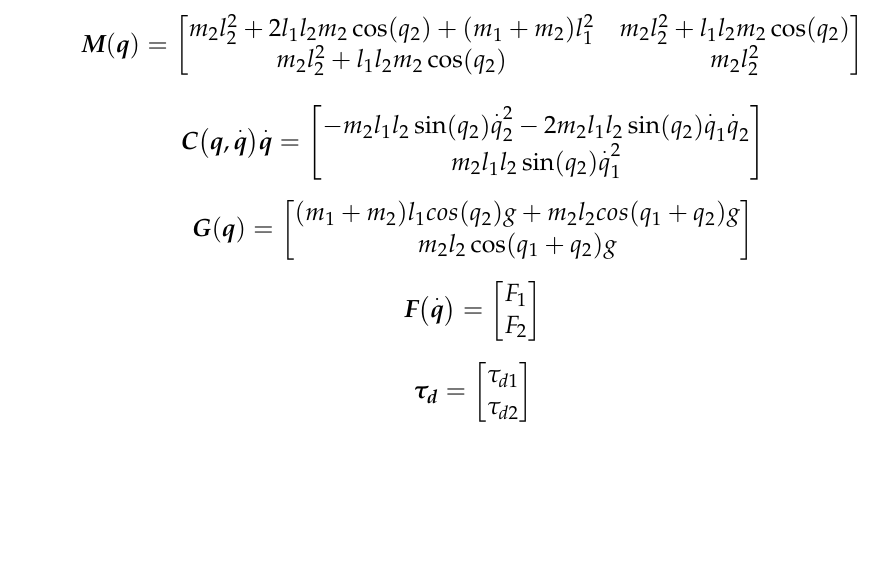
Figure 4. Proposed RL-based adaptive control scheme.